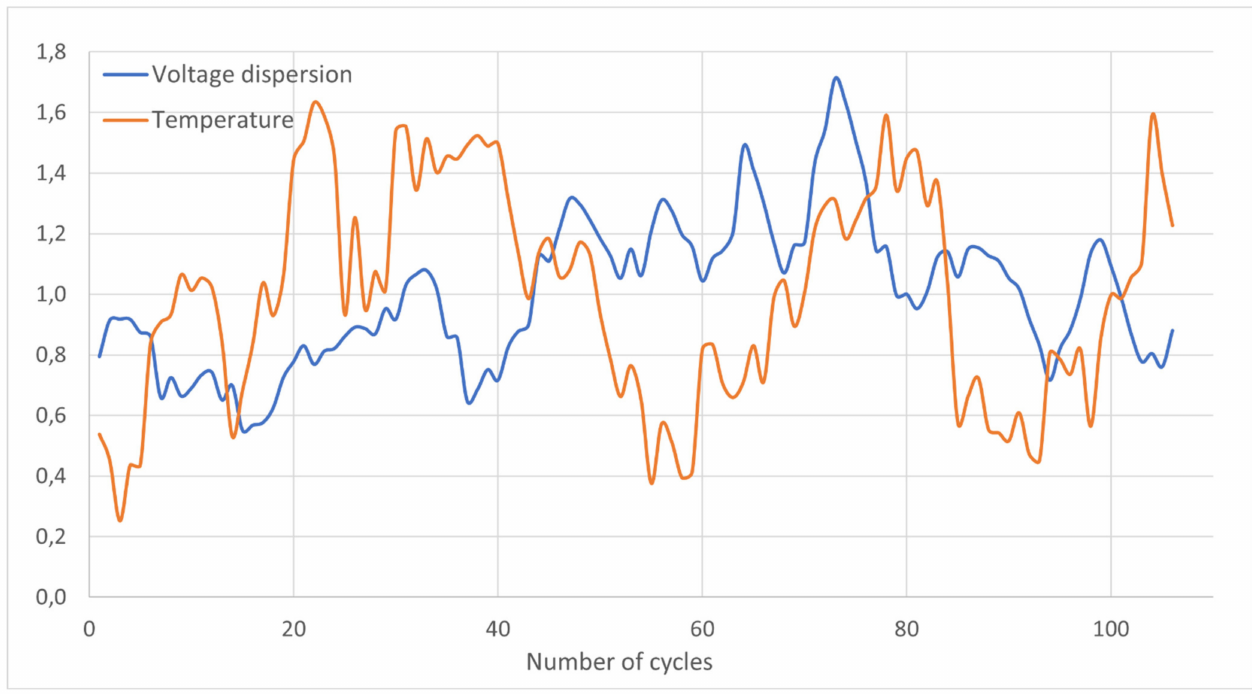
Figure 14. Voltage dispersion (w.c.) vs. temperature for battery